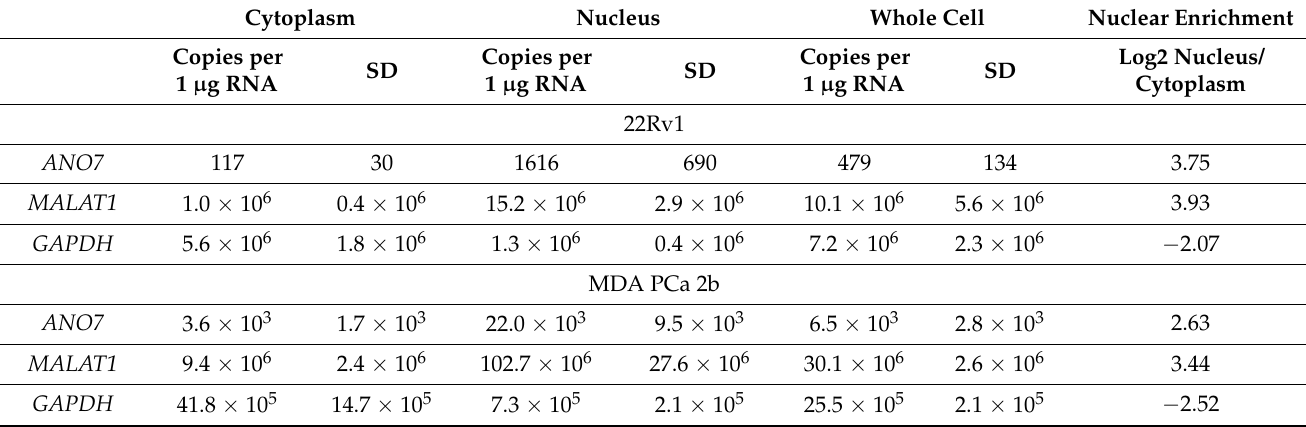
Table 2. Transcript copy numbers in whole-cell, cytoplasmic and nuclear